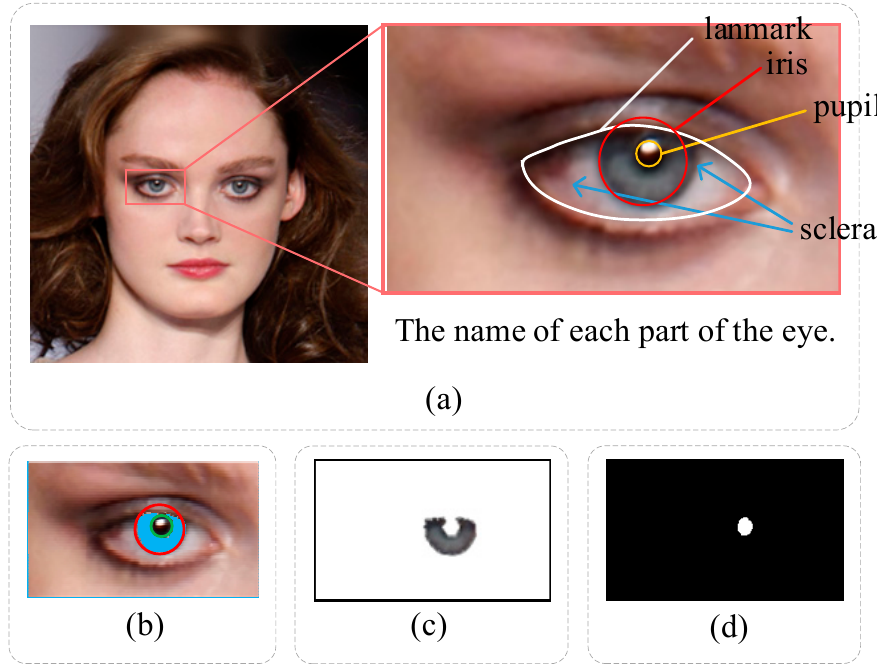
Figure 3. Schematic diagram of eye detection. ( a ) interception of the eye region. ( b ) the iris and pupil regions were segmented by EyeCool. ( c ) the iris region for color detection. ( d ) the pupil region for shape detection.